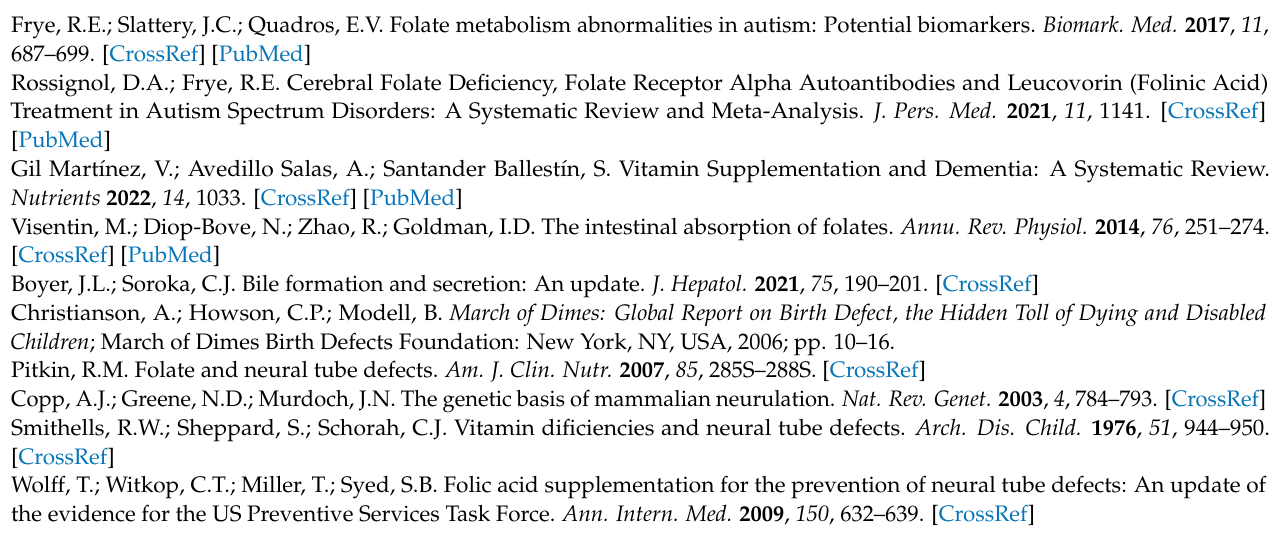
Figure S1: Preferred Reporting Items for Systematic Reviews and Meta-analysis (PRISMA) flowchart. Figure S2: Funnel plot and Egger’s Test for bias and heterogeneity. Figure S3: Funnel plot and Egger’s Test for bias and heterogeneity. Figure S4: Funnel plot and Egger’s Test for bias and heterogeneity. Figure S5: Funnel plot and Egger’s Test for bias and heterogeneity. Figure S6: Funnel plot and Egger’s Test for bias and heterogeneity. Figure S7: Funnel plot and Egger’s Test for bias and